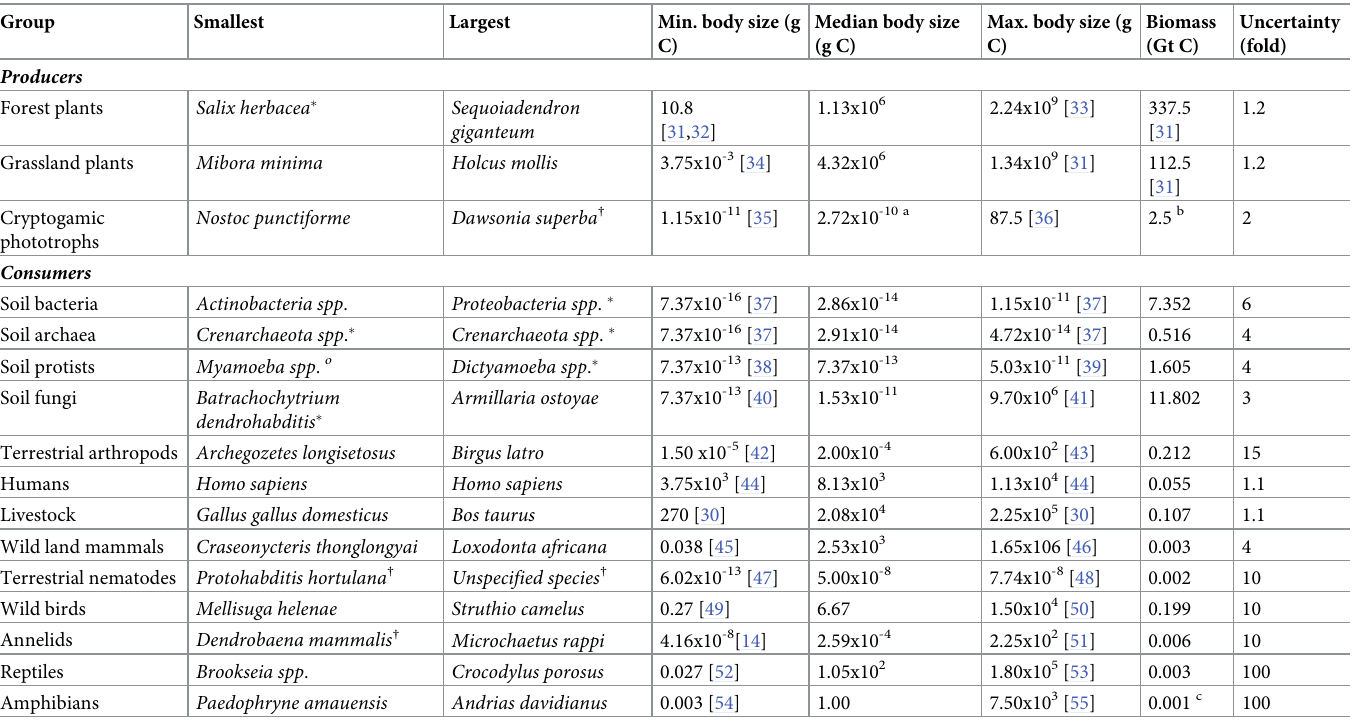
Table 2. Terrestrial body sizes and biomasses.